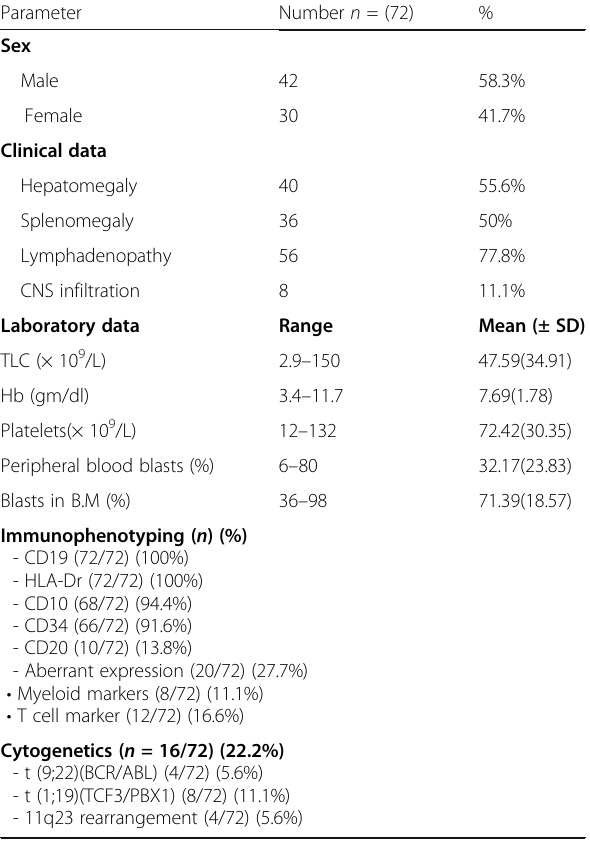
Table 1 Baseline characteristics of studied patients at diagnosis